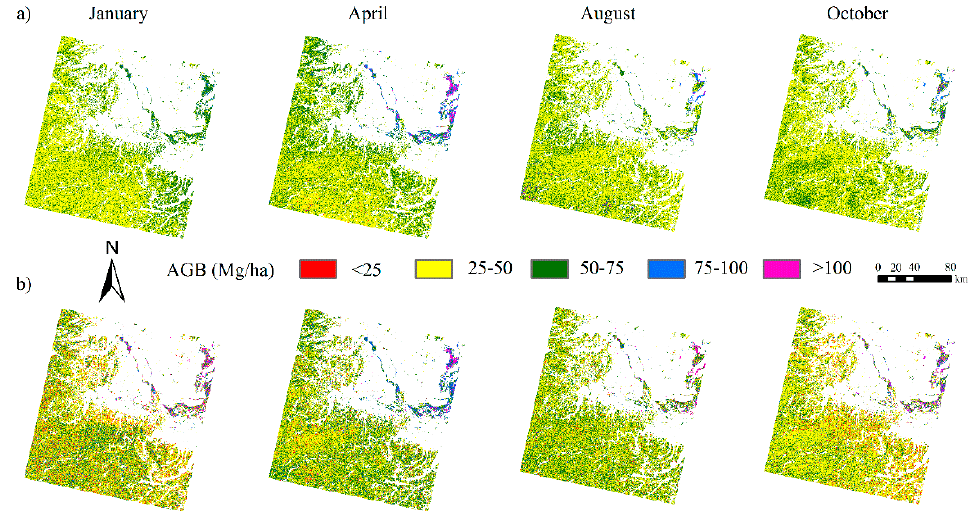
Figure 5. Spatial distribution of forest aboveground biomass (AGB) using seasonal images under different scenarios: ( a ) The total vegetation; ( b ) forest types including coniferous forest, broadleaf forest and mixed forest.